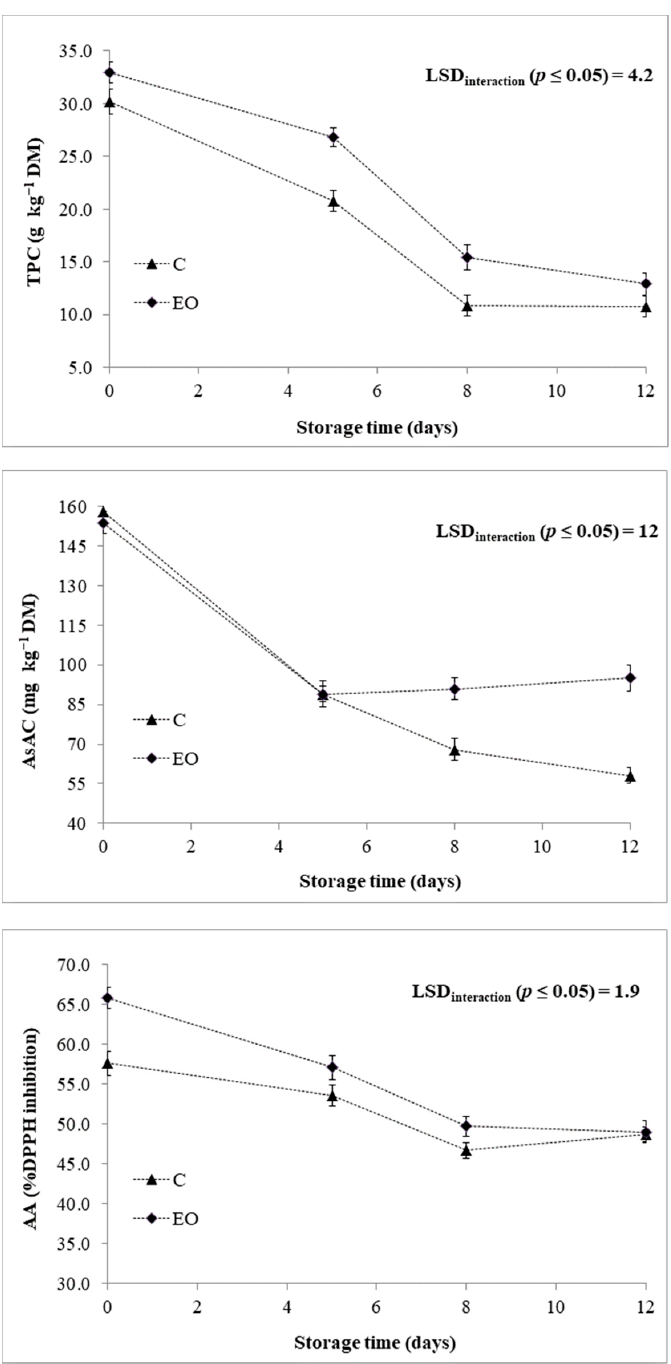
Figure 5. Chemical traits of RTC globe artichoke slices as affected by “post-harvest treatment × storage time” interaction. TPC: Total polyphenol content; AsAC: Ascorbic acid content; AA: Antioxidant activity; C: Control; EO: Samples packed with essential oil of F. vulgare. Data are presented as means ± standard deviation.